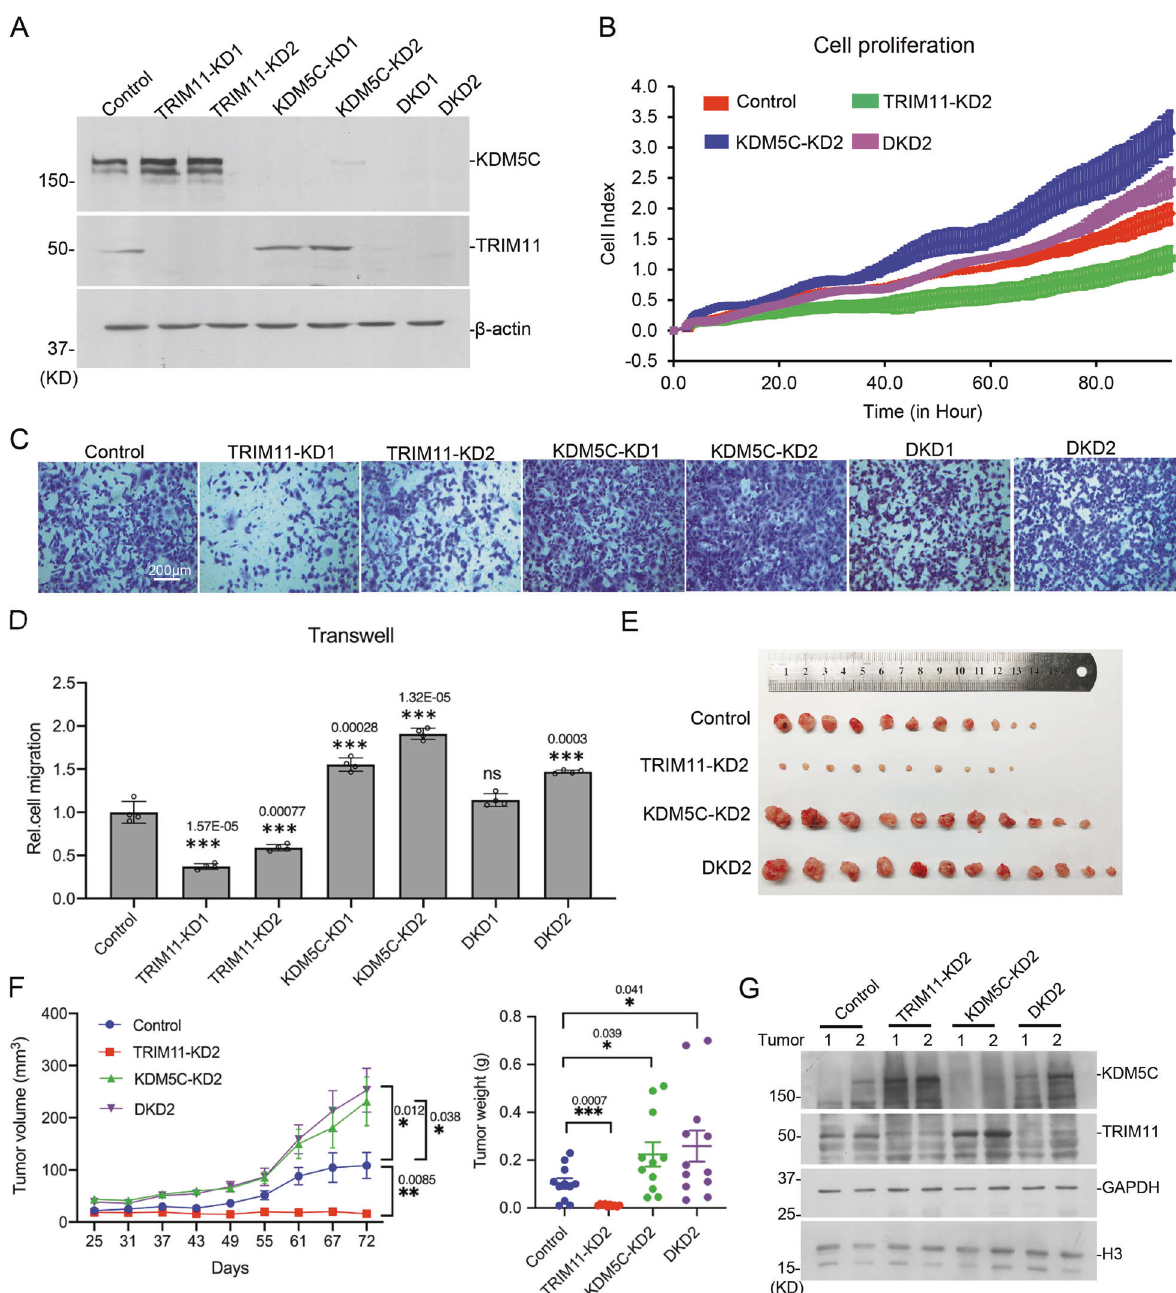
Fig. 3 TRIM11 promotes proliferation and migration of breast cancer cells via degrading KDM5C. A TRIM11 knockdown (TRIM11-KD), KDM5C knockdown (KDM5C-KD) and Double knockdown (DKD) MDA-MB-231 cell lines were constructed using CRISPR/Cas9 system. Two sgRNAs were designed per gene. B Cell proliferation of the cells in ( A ) were monitored with real-time cell analysis (RTCA). C , D Cell migration of the above cell lines were tested by transwell assay. Four views of the cell migration images were taken for each cell line. The number of moving cells was counted by image J. Bar = 200 μ m. E The indicated stable cells derived from MDA-MB-231 were injected into nude mice. The tumors were dissected and pictured. F Tumor growth curve (left) and tumor weight (right) were shown as mean ± SEM. * p value ≤ 0.05, ** p value ≤ 0.01, *** p value ≤ 0.001. G Two tumors from each group was random picked and assayed with western blotting to con fi rm they are from original cell